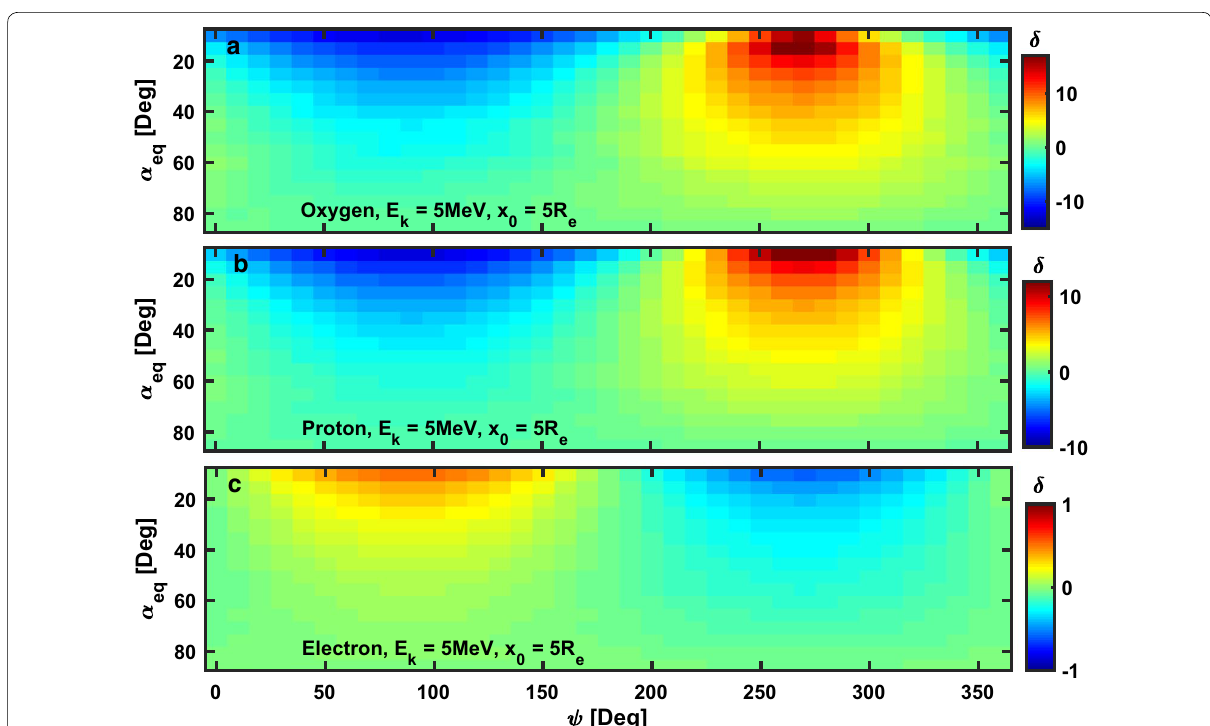
Fig. 10 The deviation in simulated magnetic mirror point latitude from their respective theoretical value as a function of initial gyro-phase for different equatorial pitch angle. a is for oxygen ion, b is for proton, and c is for electron of energy E k = 5MeV and L = 5 with initial position [ x 0 = L , y 0 = 0, z 0 = 0 ] . The magnitude of the deviation is shown by the colour